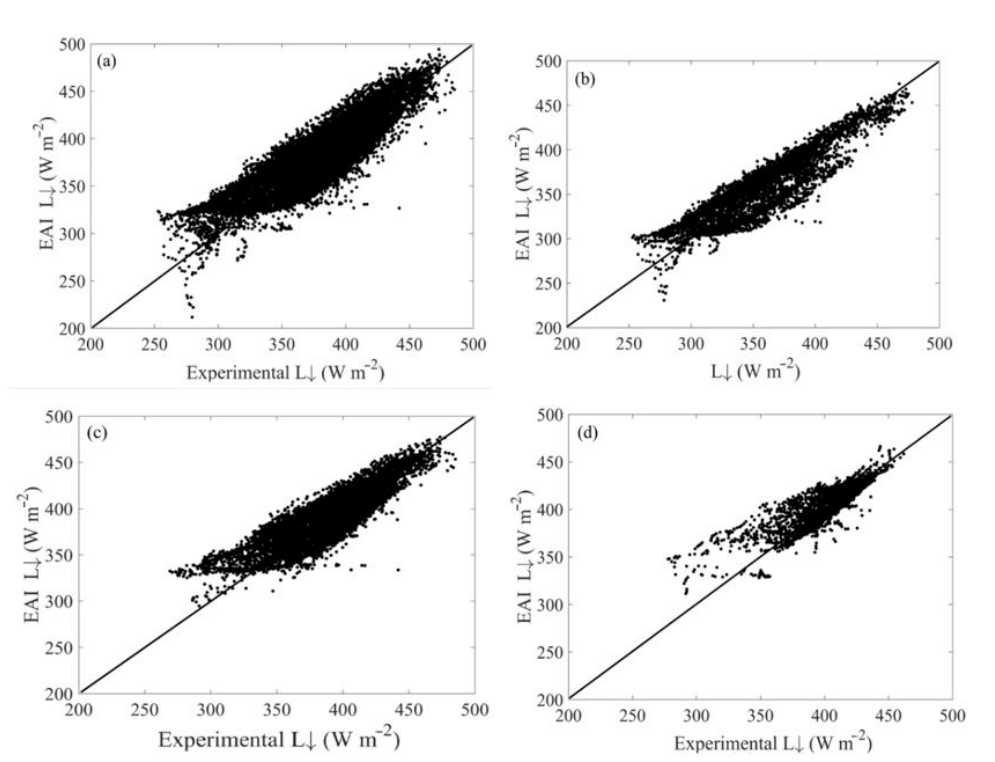
Figure 2. Half hour correlation between experimental and estimated L ↓ using the calibrated proposed equation (EAI), for SMA in 2014 ( a ) EP—entire period; ( b ) CS—clear sky; ( c ) CP—partly cloudy sky; ( d ) CD—cloudy sky. The statistics indices are shown in Table 4.